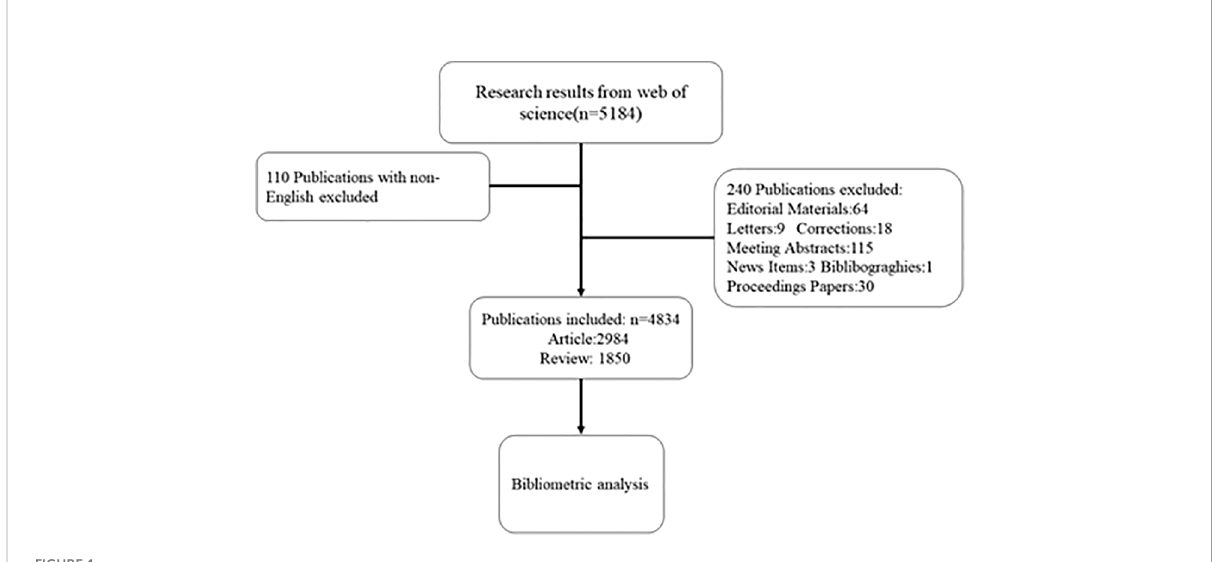
FIGURE 1 Retrieval process fl owchart for the